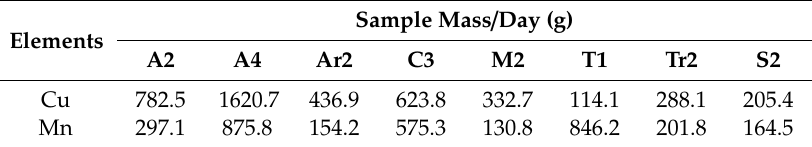
Table 6. Sample mass that can be consumed by day for trace elements.